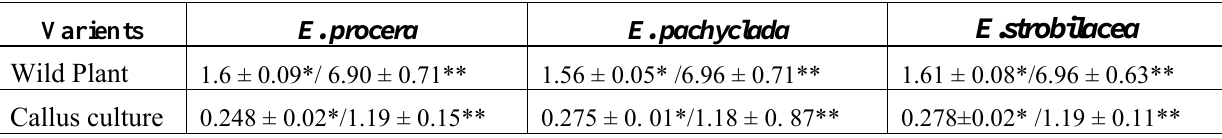
Table 3. Wild plant and callus culture antioxidant comparing efficiency of three species of Ephedra based on FRAP